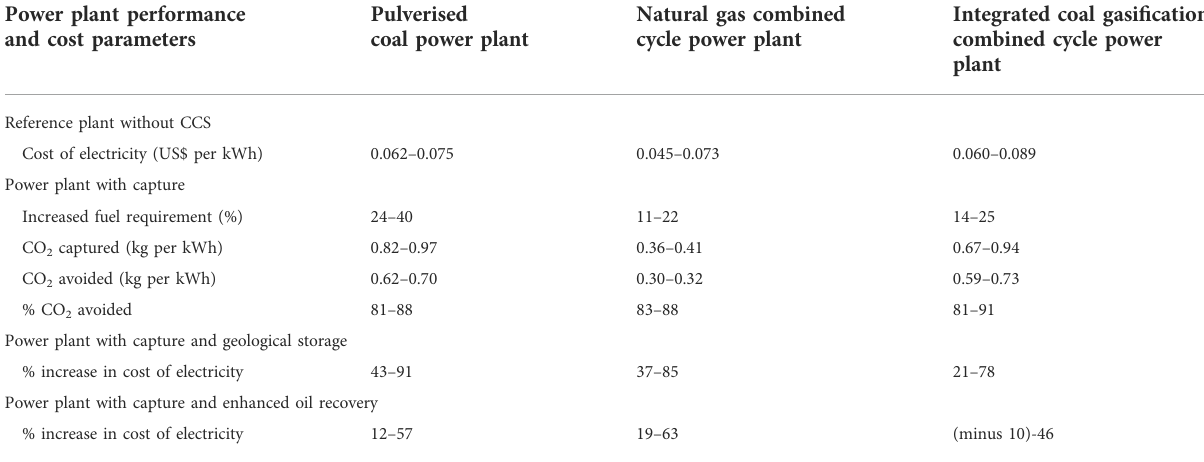
TABLE 2 The costs of CO 2 capture, transport and geological storage for new power facilities using bituminous coal or natural